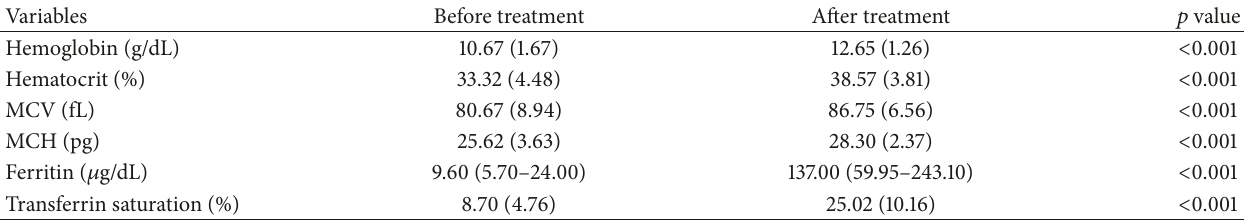
Table 2: Hematological laboratory tests before and after treatment with intravenous ferric carboxymaltose